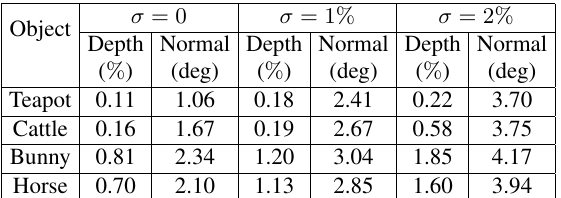
Table 1. Mean relative depth error and surface normal mean